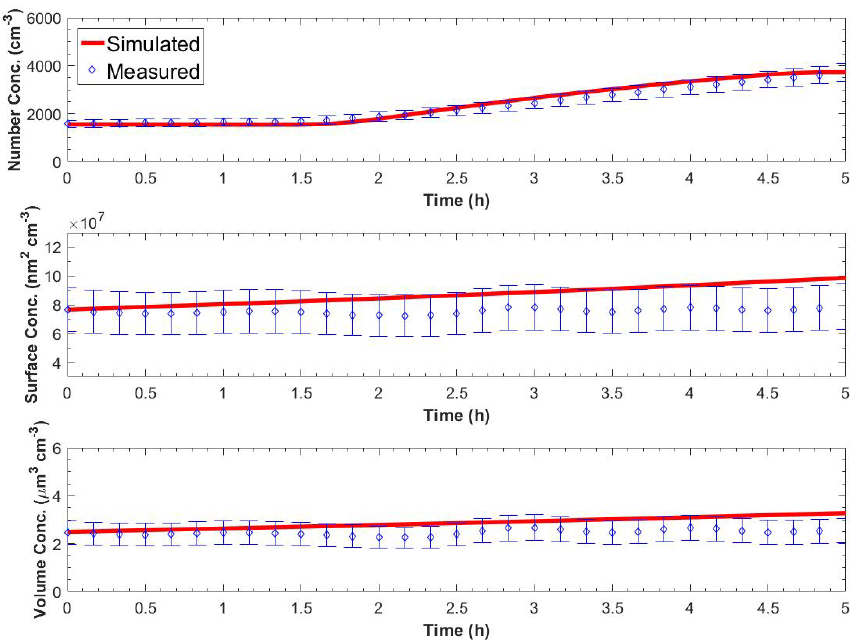
Figure 6. Measured and simulated number, surface, and volume concentration in the perturbed chamber after turning UV lights on for Exp. A1. The error bars in the measured values are calculated from the uncertainty in the particle wall loss correction and represent two standard deviations.